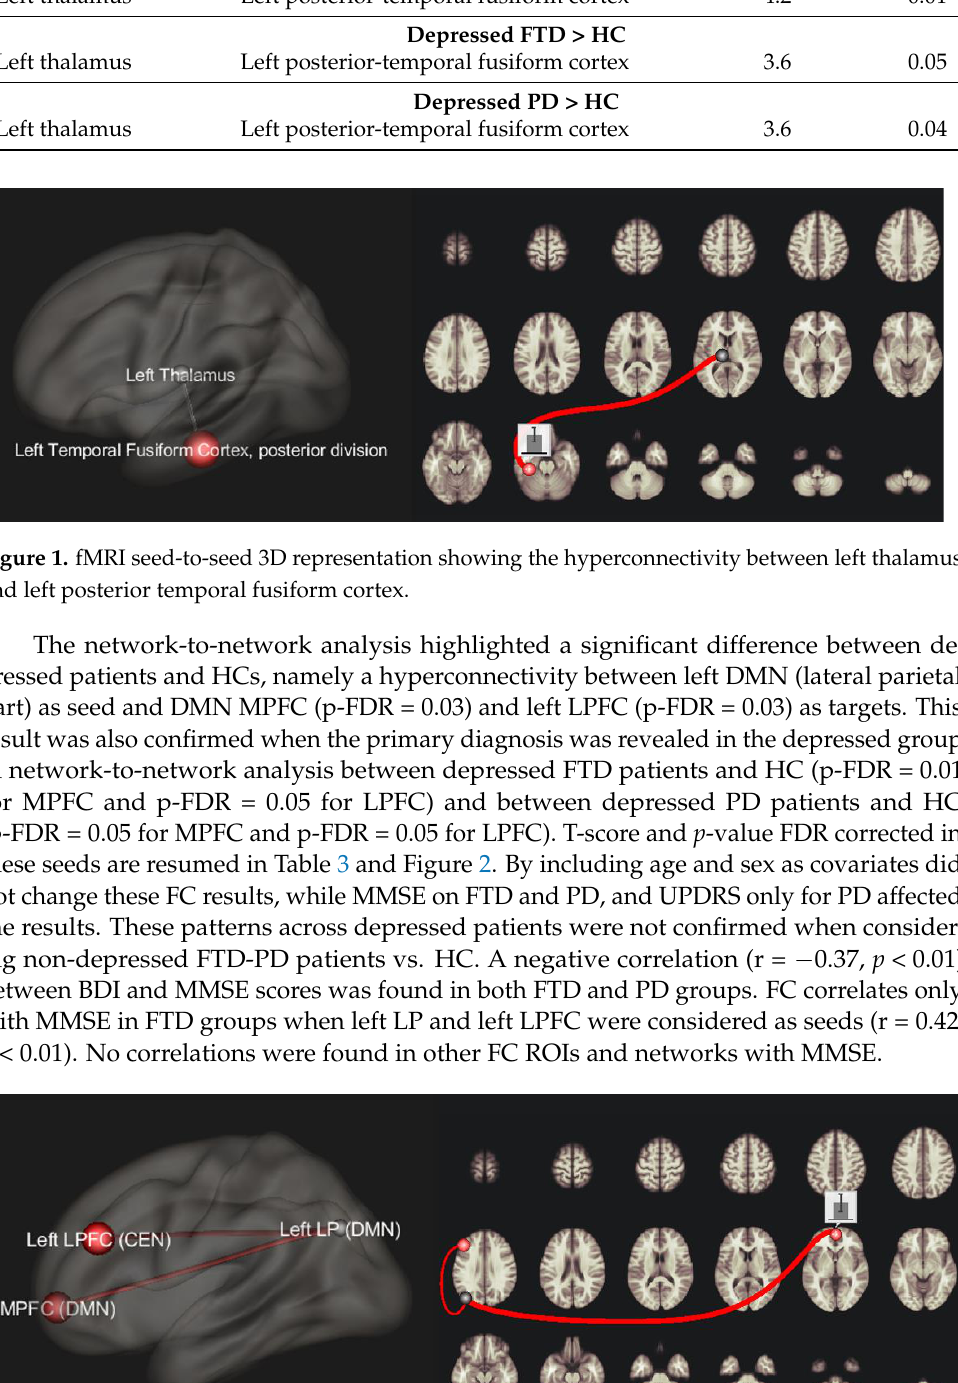
Figure 2. fMRI network-to-network 3D representation showing the hyperconnectivity between the left lateral parietal cortex (LP), left lateral prefrontal cortex (LPFC), and medial prefrontal cortex (MPFC).